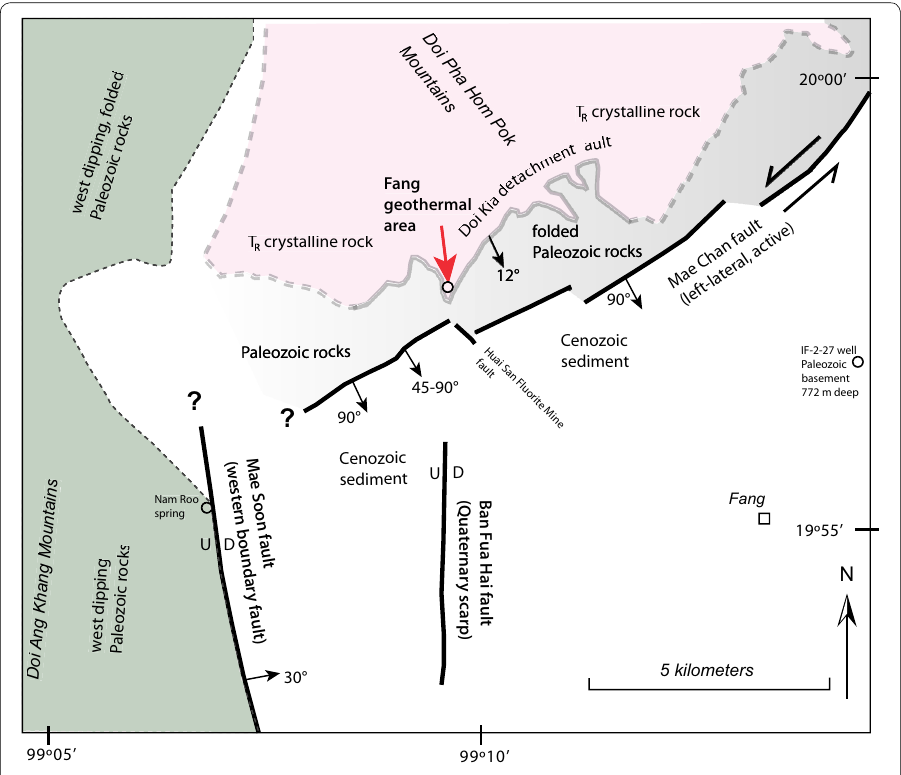
Fig. 4 Map showing fault relationships in the Fang basin at the west end of the Mae Chan